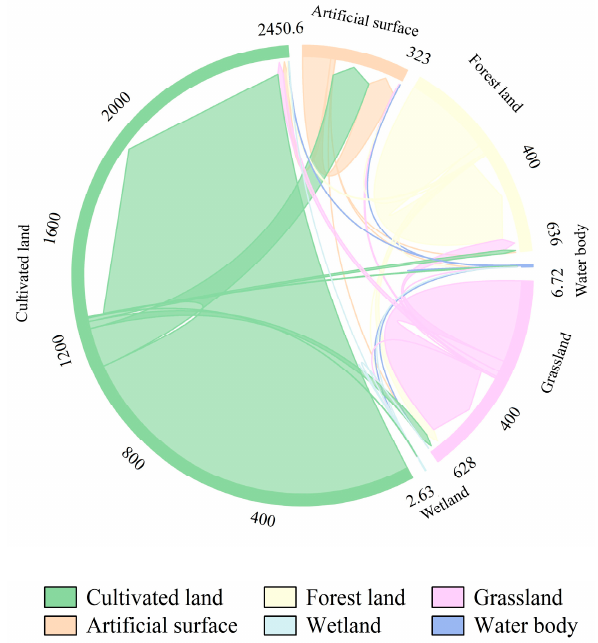
Figure 7. LUCC in mining areas of Changzhi City between 2000–2020.